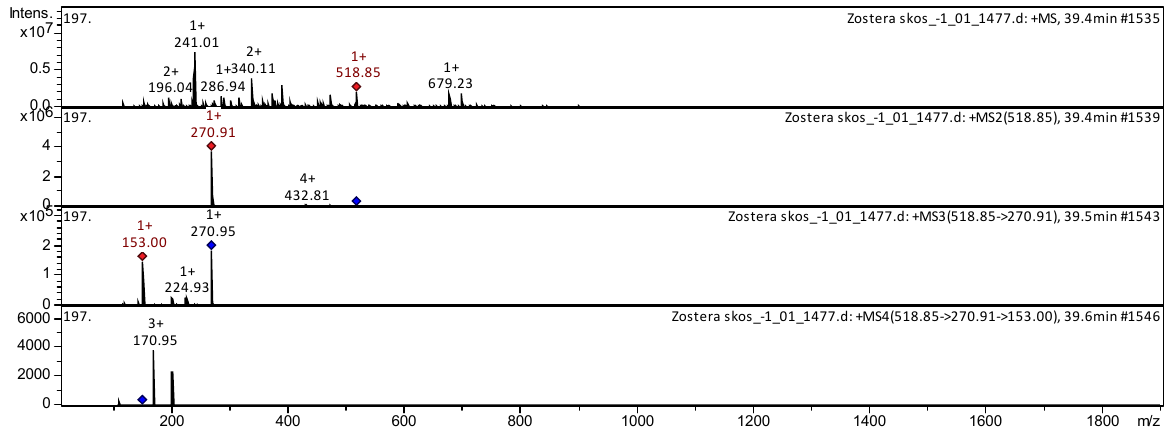
[M+H] + ion produced one fragment ion with m/z 270.90. (Figure 8). The fragment ion with m/z 270.90 formed five daughter ions with m/z 152,88, m/z 224,93, m/z 202,95, m/z 162,85, and m/z 118.96. It was identified in the bibliography in extract from Rubus ulmifo- lius [13] ; Strawberry [14] ; Vigna unguiculata [15]. The CID spectrum in positive ion modes of anthocyanin Pelargonidin 3- O -(6- O -mal- onyl-beta-D-glucoside) from Z. marina is shown in Figure 9. [M+H] + ion produced two fragment ions with m/z 270.91, and m/z 432.81 (Figure 9). The fragment ion with m/z 270.91 formed two daughter ions with m/z 153.00, m/z 224.93. It was identified in the bibliography in extract from Strawberry [14], Wheat [16]. Figure 8. CID spectrum of Pelargonidin 3- O -glucoside acid from Z. marina , m / z 432.55.